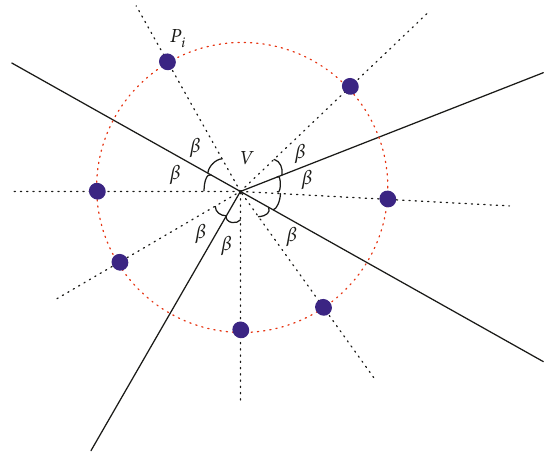
Figure 6: Illustration of vertex definition.